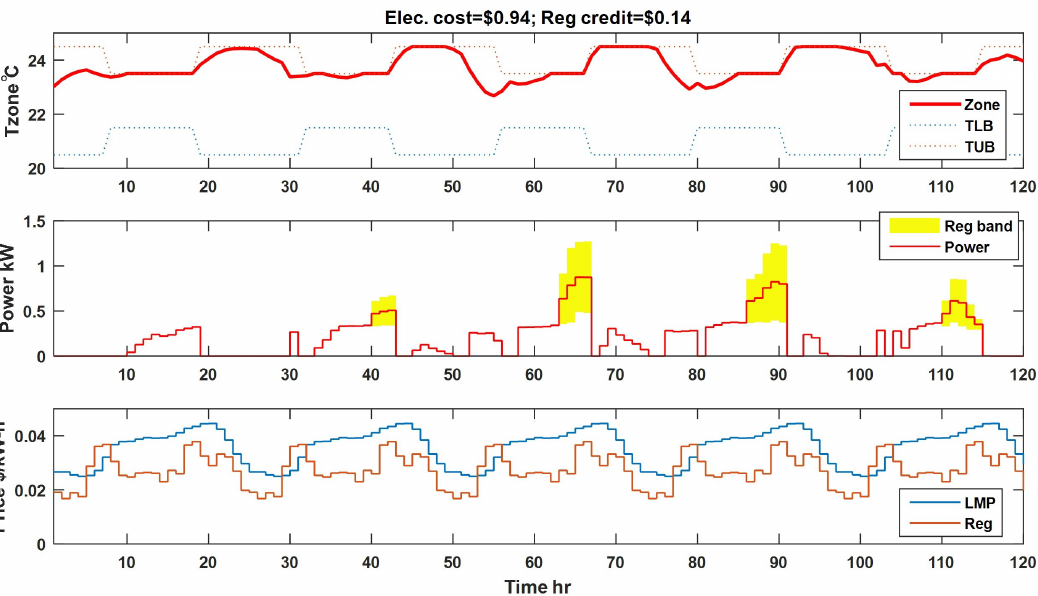
Figure 9. BaseControl II results.